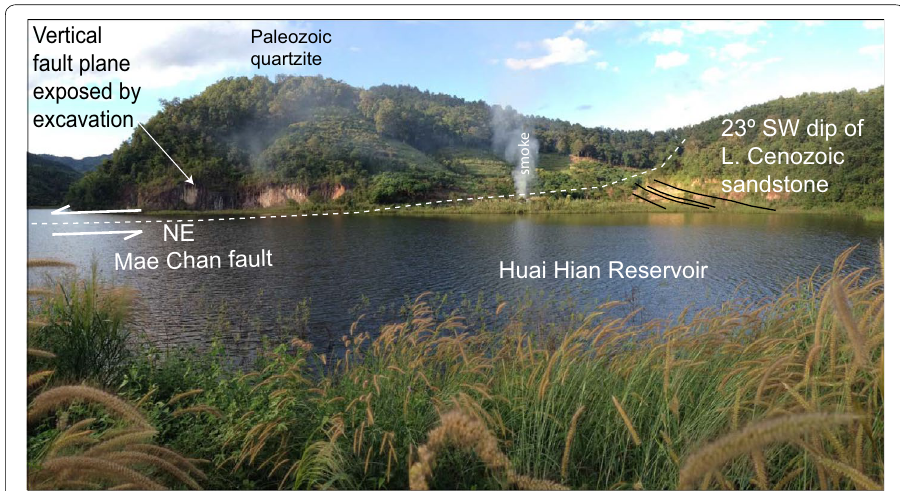
Fig. 25 Exposure of the Mae Chan fault at the reservoir of Huai Hian (creek), 3 km NE of the Fang geothermal area. Photo looking north from 0519800E,